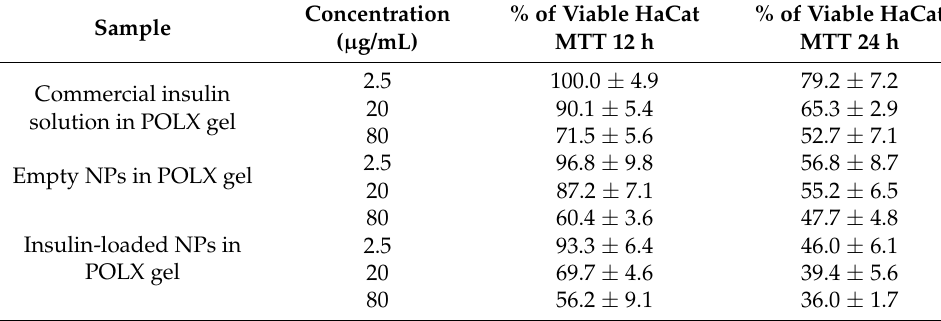
Table 2. HaCaT cell viability (%) of commercial (free insulin) in Pluronic ® F127 (POLX) gel, empty NPs in POLX gel, and insulin-loaded NPs in POLX gel for 12 h and 24 h. All data are presented as mean ±